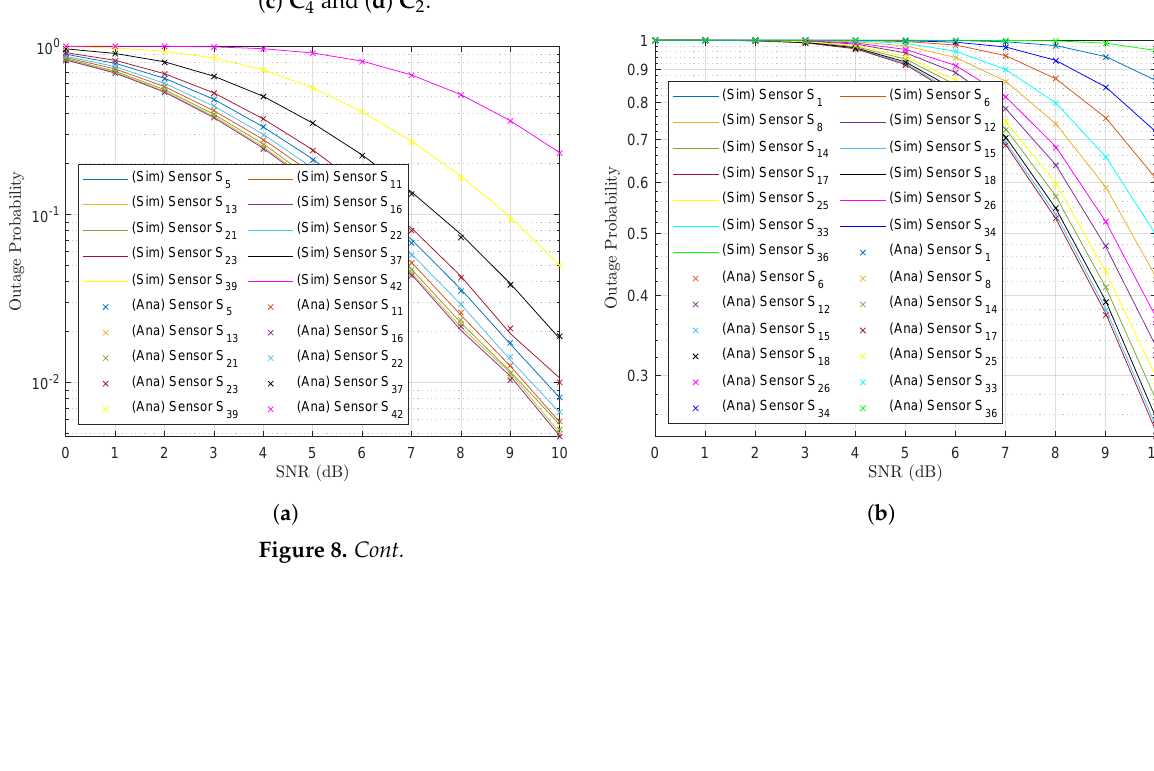
Figure 7. Outage probability at the UAV for the UAV’s subcluster trajectory sequence ( a ) C 1 , ( b ) C 3 , ( c ) C 4 and ( d ) C 2 .